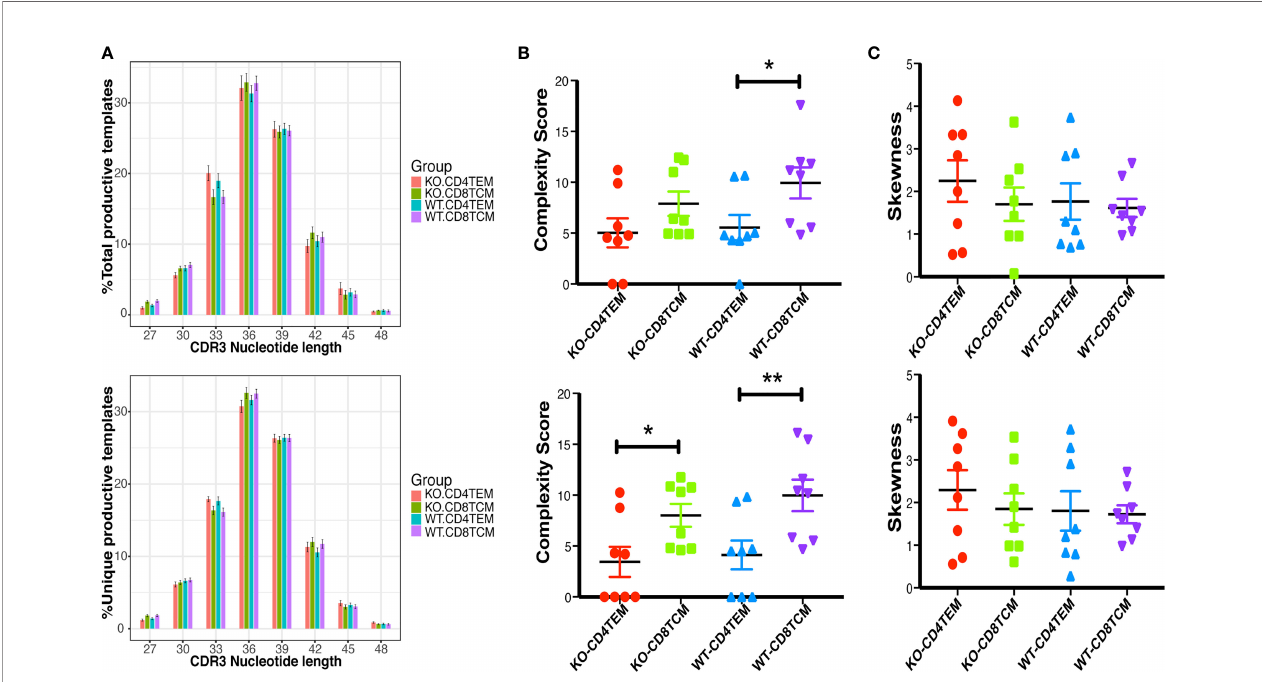
FIGURE 7 | Distribution of the length of CDR3 b nucleotide of CD4 + TEM cells or CD8 + TCM cells from WT and KO chimeras. Distribution of the length of the CDR3 b region of TRB total sequences (up) and unique sequences (down) (A) . Complexity scores (B) and skewness (C) of CDR3 b total sequences (up) and unique sequences (down). *p < 0.05, **p <